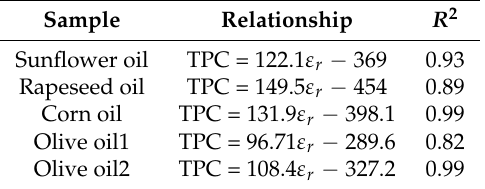
Table 2. Correlation between TPC (total polar compounds) and relative permittivity ε r .